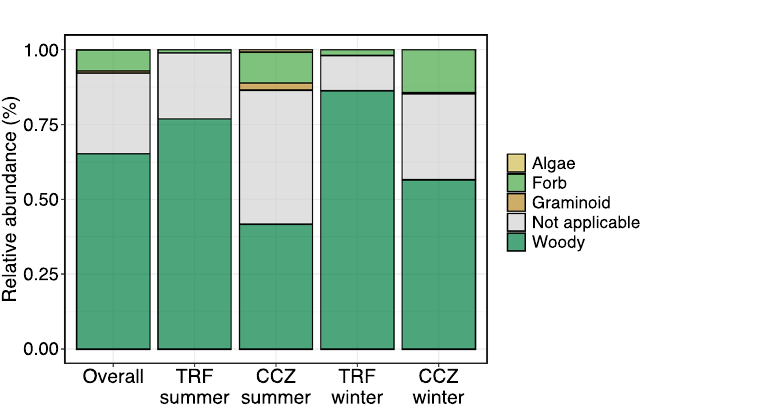
Figure 6. Relative abundance of plants classified by growth morphology. The mean relative abundance of samples in each group is